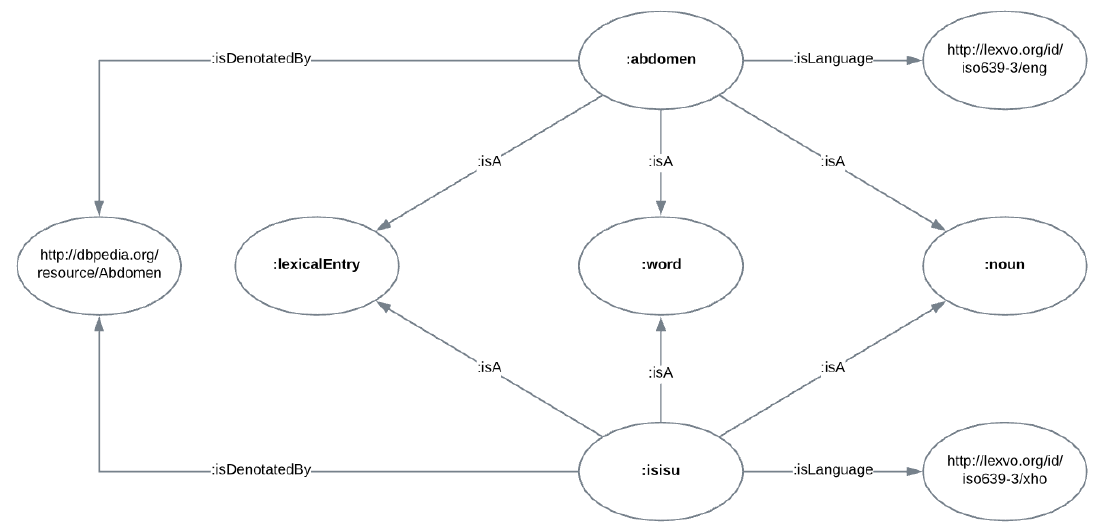
Figure 2. Visualisation of the lexical entries Abdomen and Isisu .